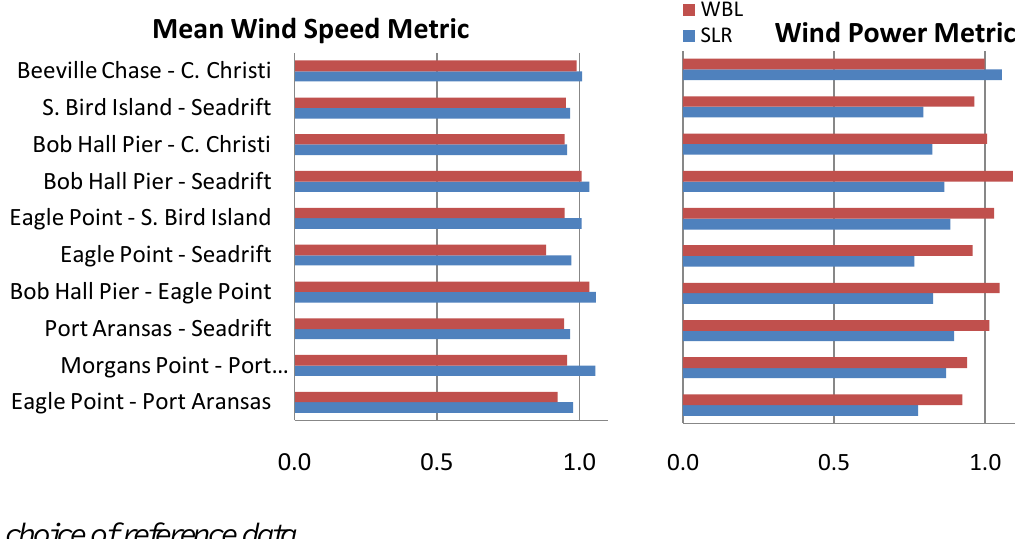
Figure 16. Mean wind speed and wind power density metrics (=predicted/true wind speed and wind power density, respectively) for the 10 pairs of sites